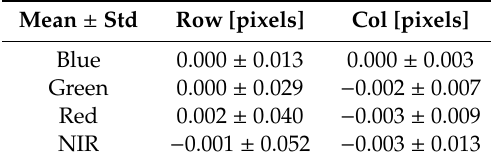
Figure 9. Differences in rows and columns in coordinates between MS and PAN images after attitude change compensation. Table 8. Differences in rows and columns in coordinates between MS and PAN images after attitude change compensation.